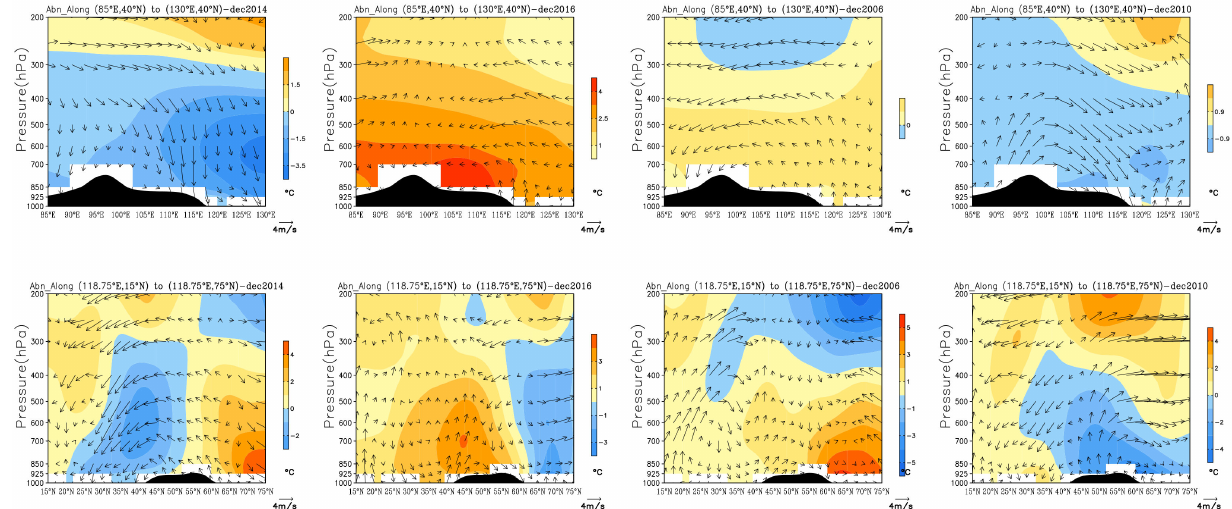
Figure 11. Cross sections of the east − west ( top ) and north − south ( bottom ) circulations and the temperature in strong Q 1 − strong EAWMI year (first from left), weak Q 1 − weak EAWMI year (second from left), strong Q 1 − weak EAWMI year (third from left) and weak Q 1 − strong EAWMI year (fourth from left) in Beijing − Tianjin − Hebei